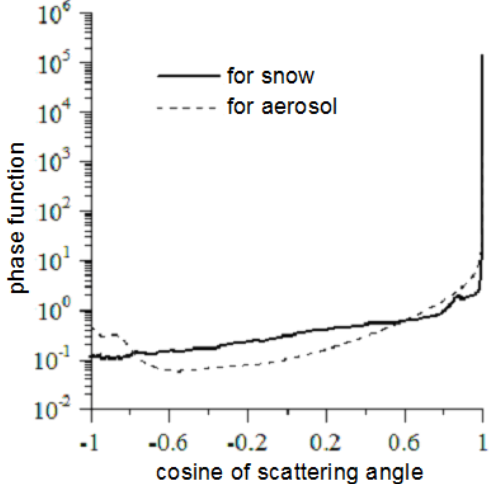
Fig. 7. The scattering phase functions. The molecular scattering is ignored and the air phase function is assumed to be equal to that of atmospheric